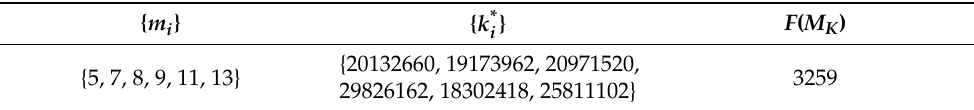
Table A4. Pre-computed constants for error detection using